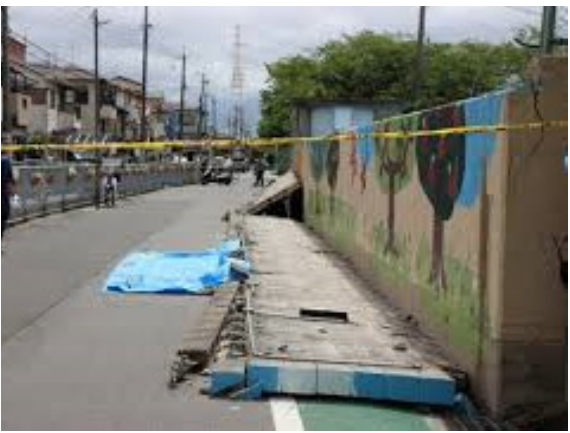
Figure 2. Masonry wall damage of Northern Osaka earthquake, Japan (2018).